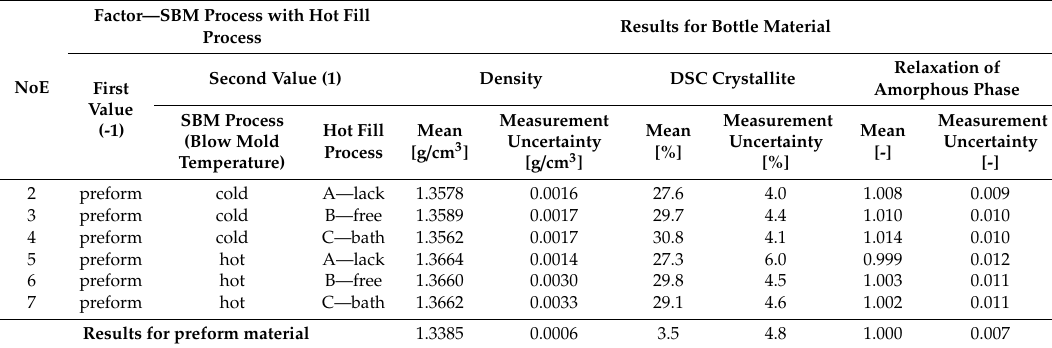
Table 6. Plans for six one-factor, bivalent experiments for testing degree of crystallinity, density, and relaxation of the amorphous phase (NoE- Number of Experiment)—samples were cut out of bottles at IV-2 thickness measurement point (base part of the bottle shown in Figure 5), and cut out of preforms at four blow kinetics marks (shown in Figure 3).